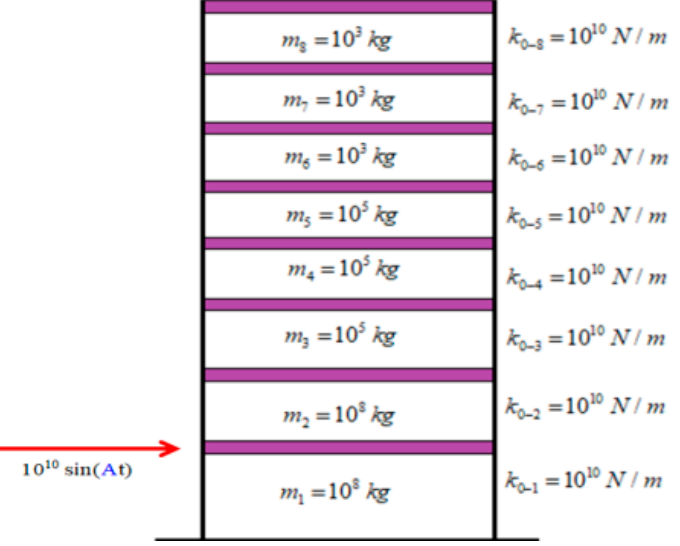
Figure 15. Eight-storey shear beam building with external force.